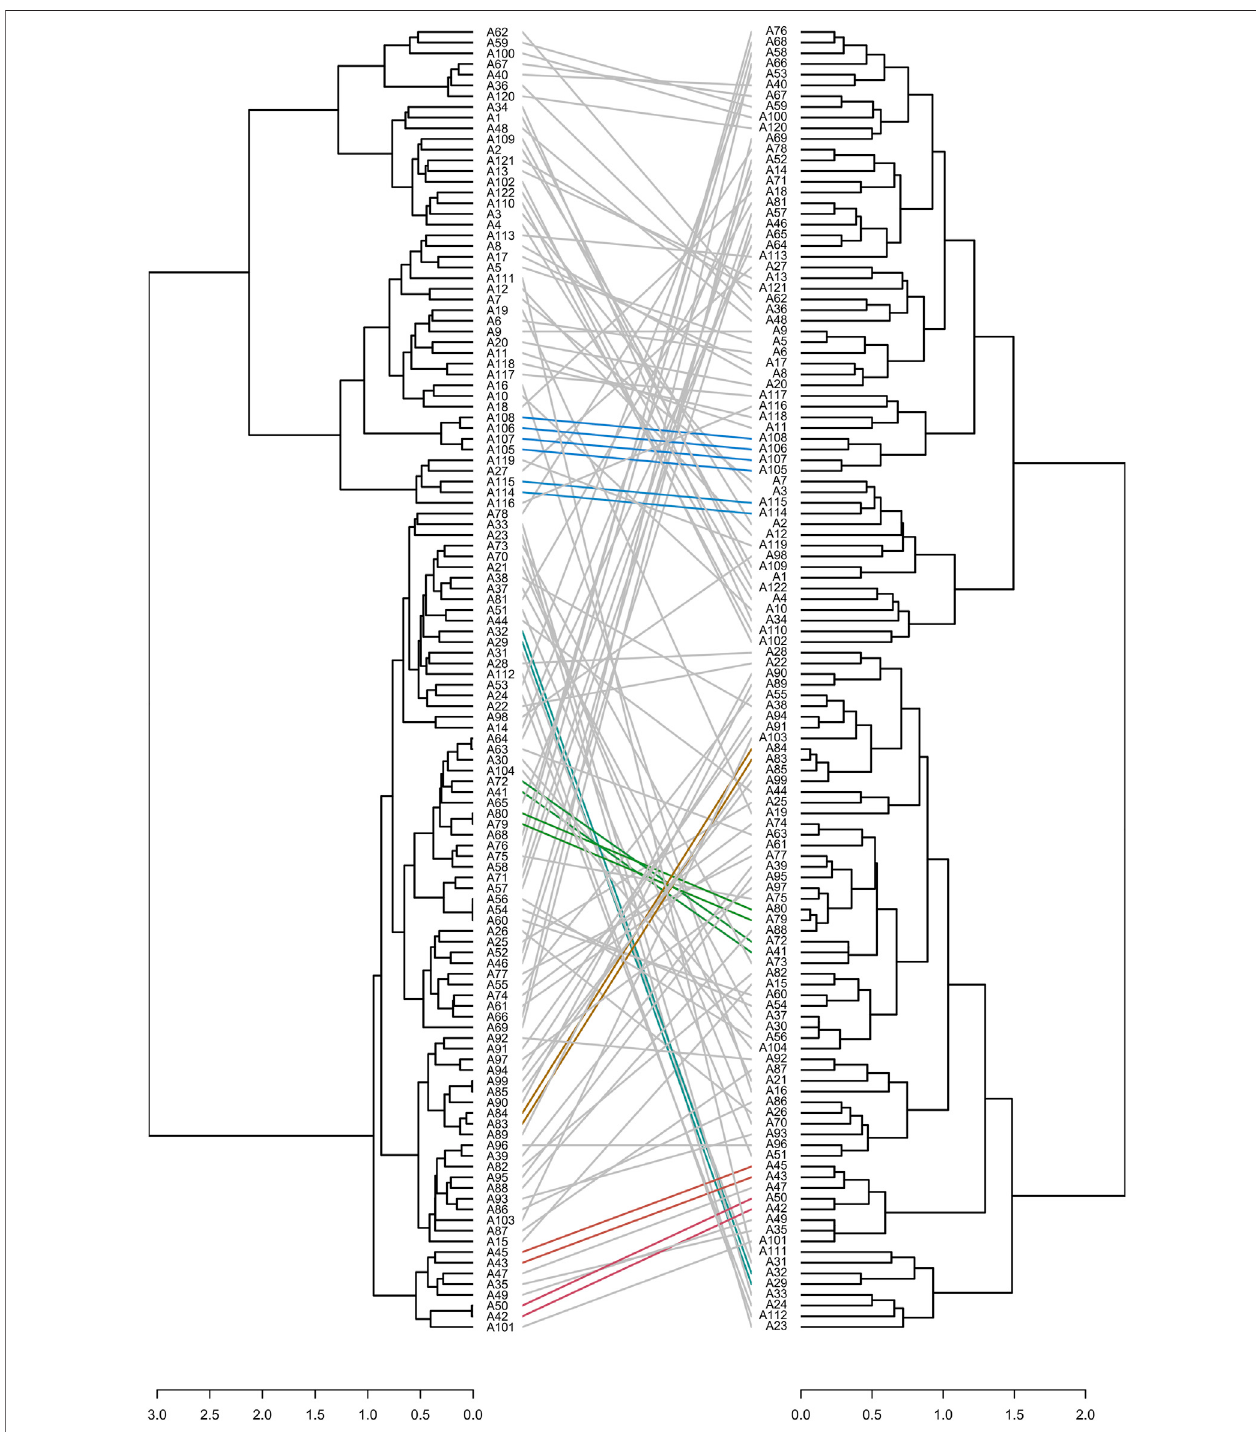
FIGURE 8 | Correspondence between molecular (left of fi gure, calculated by using the Jaccard distance) and phenotypic (right of fi gure, calculated by using the Jaccard distance) cluster analysis. Identical colored lines indicate the same cluster results.